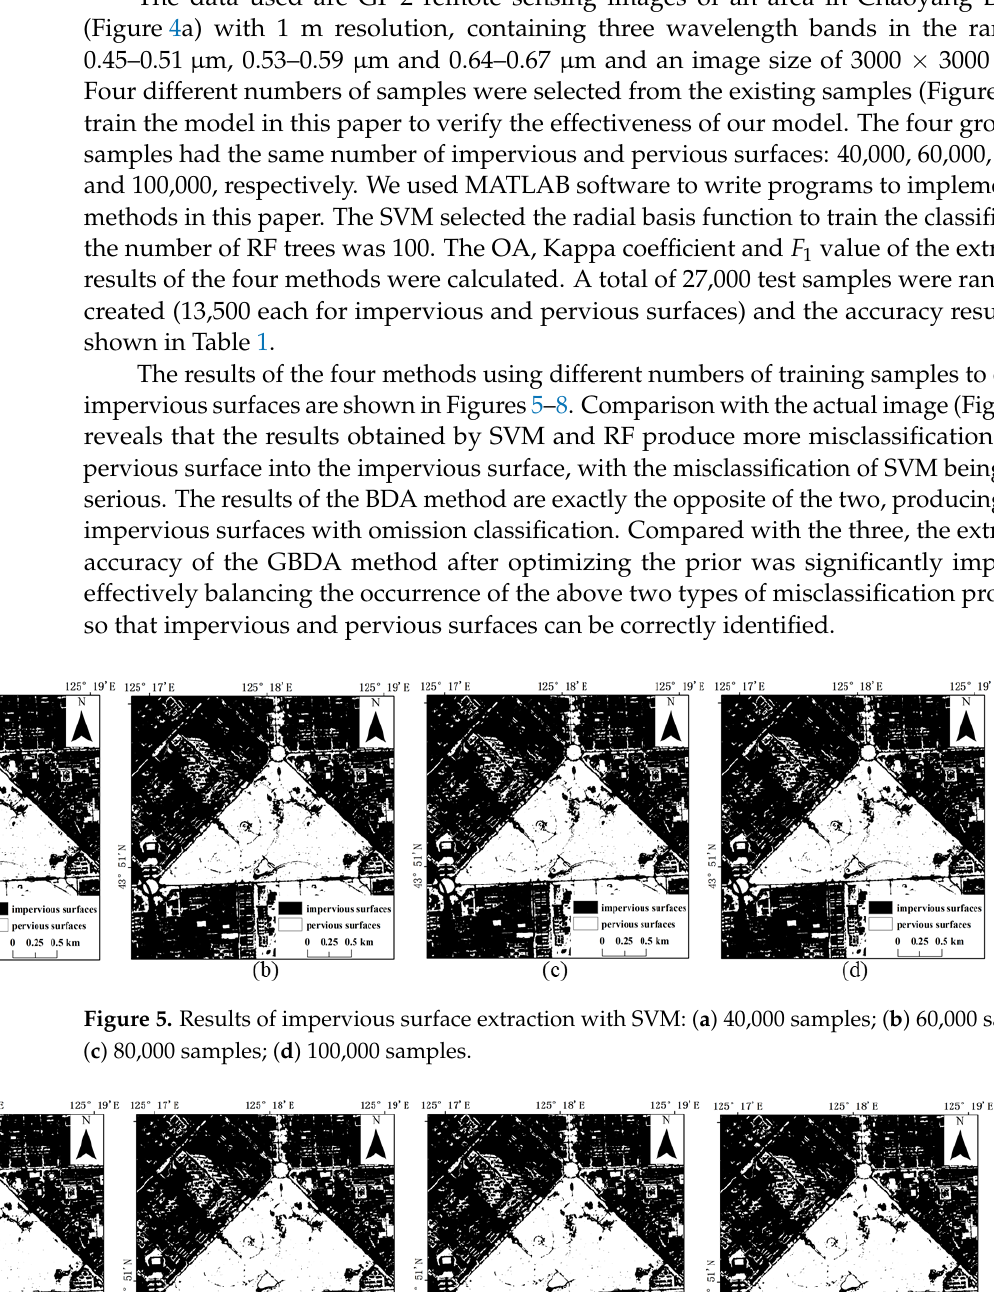
Figure 4. Image Data: ( a ) GF-2; ( b ) Sentinel-2.